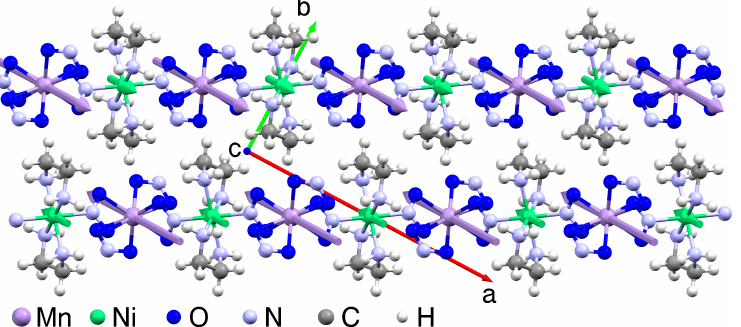
Figure 1. Two chains in the a-b plane of MnNi(NO 2 ) 4 (en) 2 , based on the crystal structure of [45]. The thick arrows on the Mn and Ni atoms show the zero-field ordered state: ferromagnetic along the chains and antiferromagnetic between